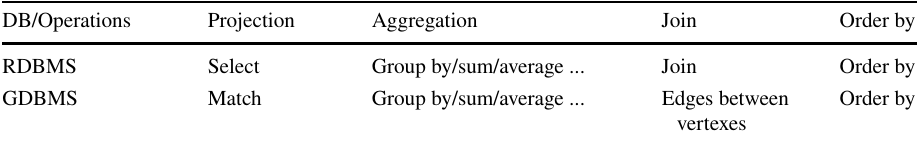
Table 6 RDBMSs’ and GDBMSs’ operations mapping